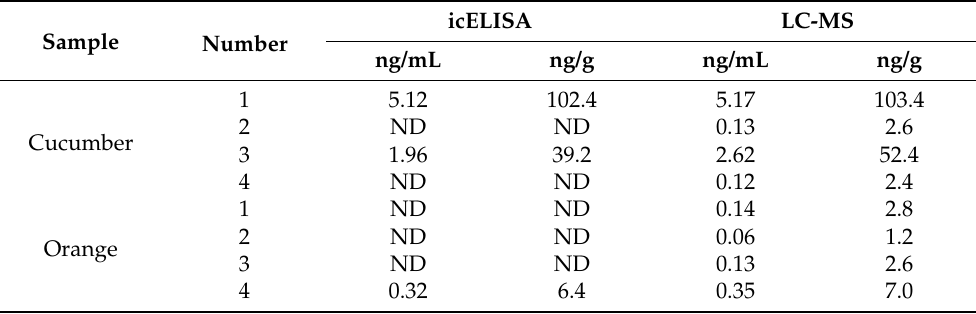
Table 4. Comparison between icELISA and LC-MS quantitative results for CPPU residues in cucum- bers and